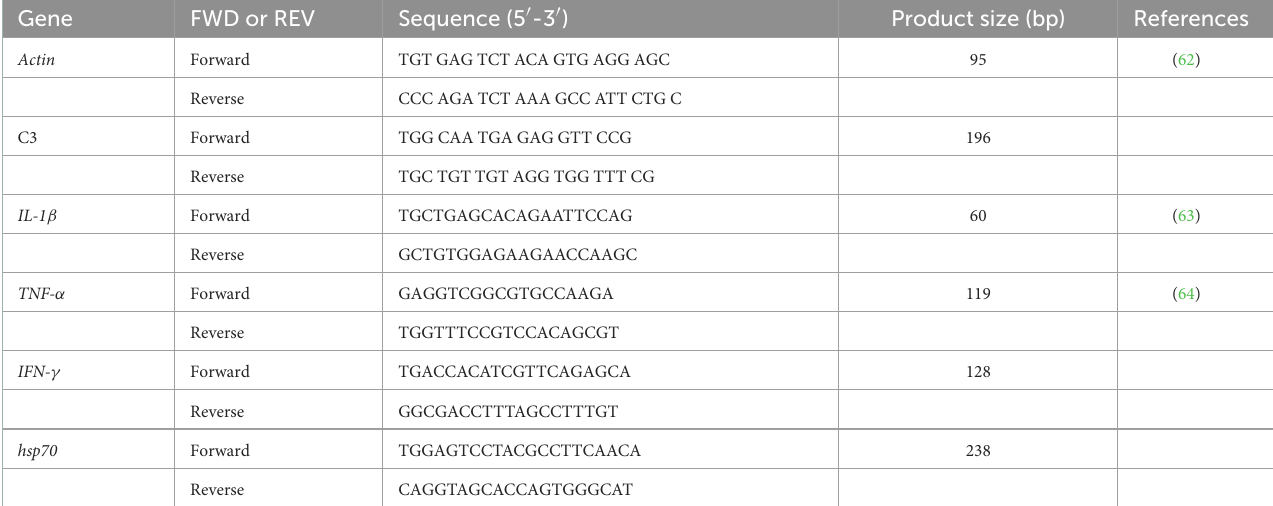
TABLE 1 Primers used for detection of a target